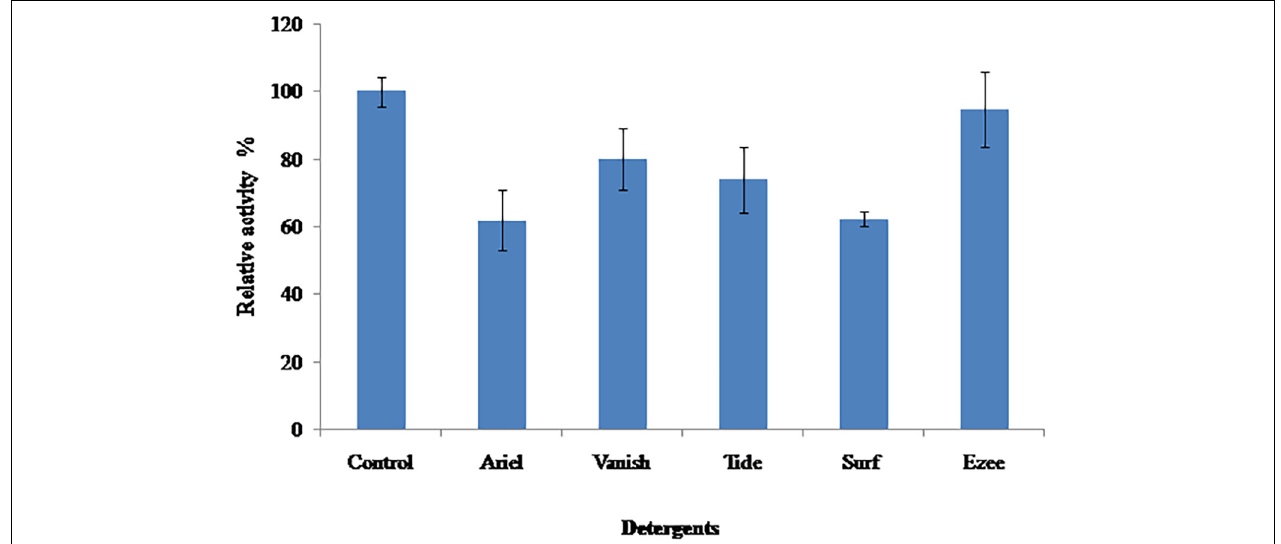
FIGURE 5 | Effect of commercial detergents on stability of